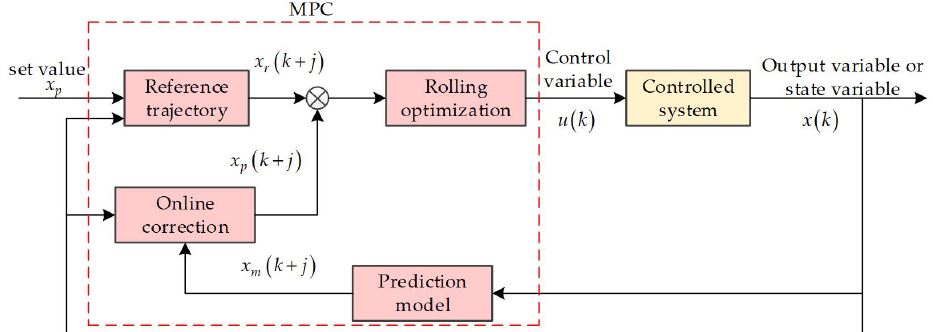
Figure 11. The principle and characteristics of